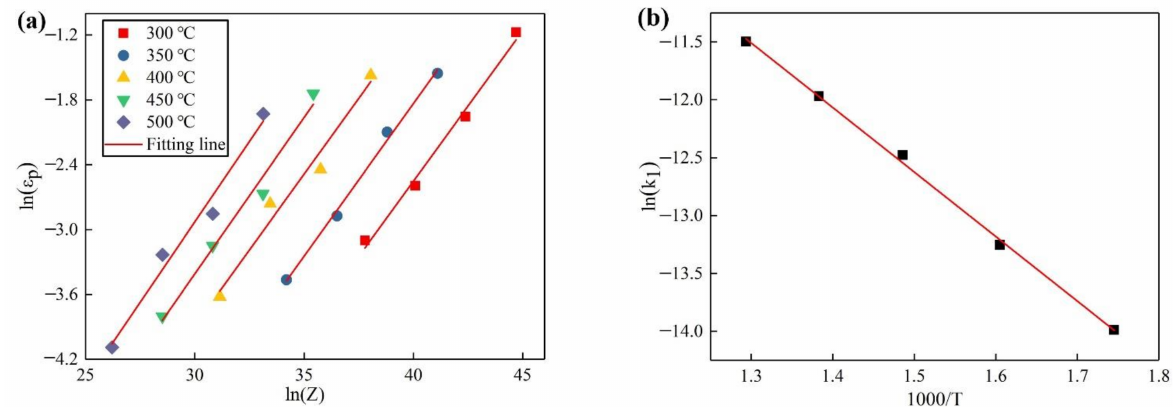
Figure 6. The relation between peak strain and Z : ( a ) the relation between Z and ln ( ε p ); ( b ) the relation between k 1 and T .